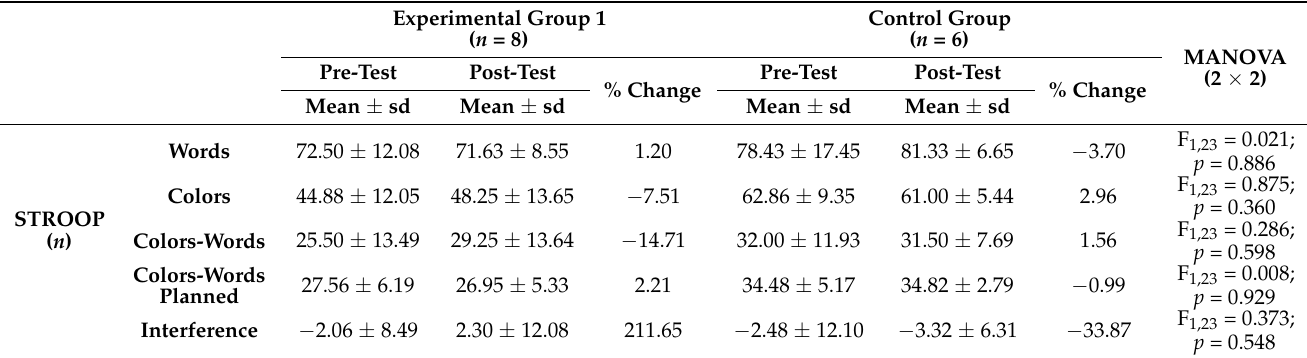
Table 4. Results obtained at the cognitive